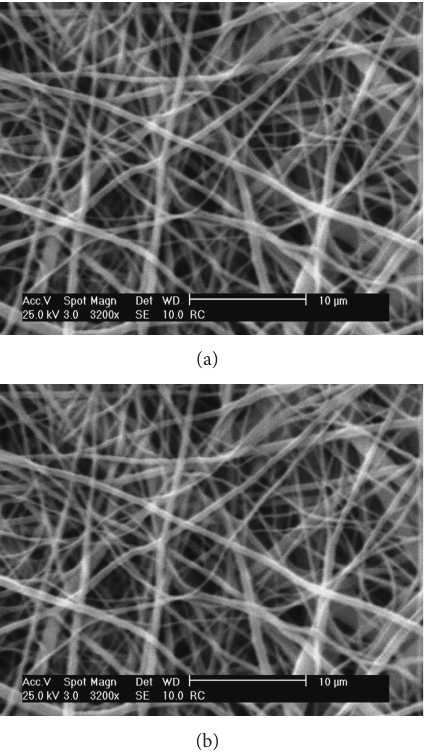
Figure 10: SEM images of the surface of the regenerated cellulose fibres at a polymer concentration of 25% (w/v). The operating voltage was 25 kV and the flow rate 0.002 (mLmin −1